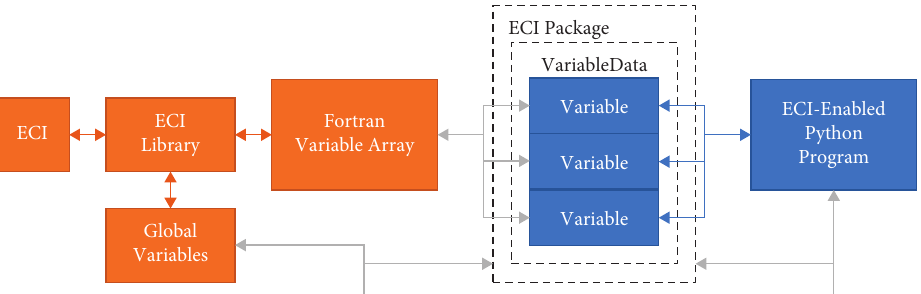
Figure 3: General ECI program hierarchy with Python interface. The ECI package and Python program are written in Python, while the ECI library and Fortran variable array are written in Fortran 90. Component variables are linked through a variable object. Global variables used for time step and program flow control are exposed directly by the interface.